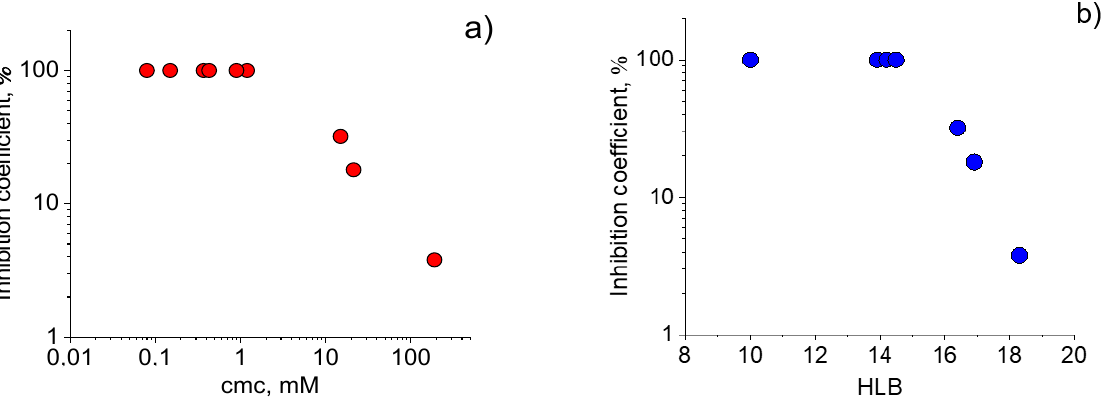
Figure 3. Inhibition coefficient as a function of: ( a ) critical micelle concentration cmc and ( b ) hydrophile-lipophile balance HLB of different cationic surfactants for SARS-CoV-2 inactivation by 0.28 mM surfactant solutions (contact time 1 h).